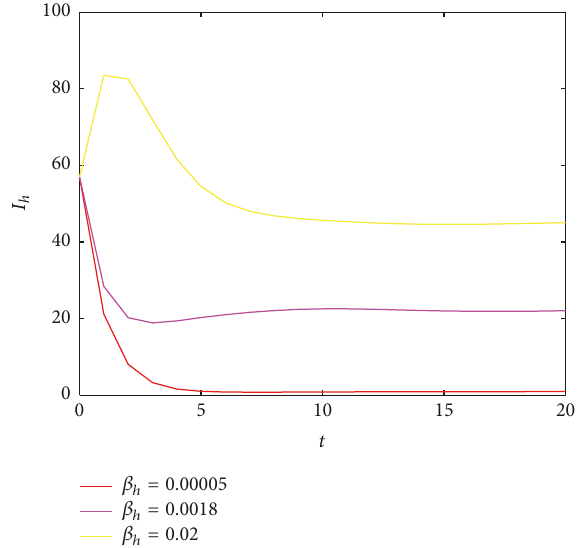
Figure 5: The curve-trend diagram of 𝐼 ℎ with time, when 𝛽 ℎ has different parameter